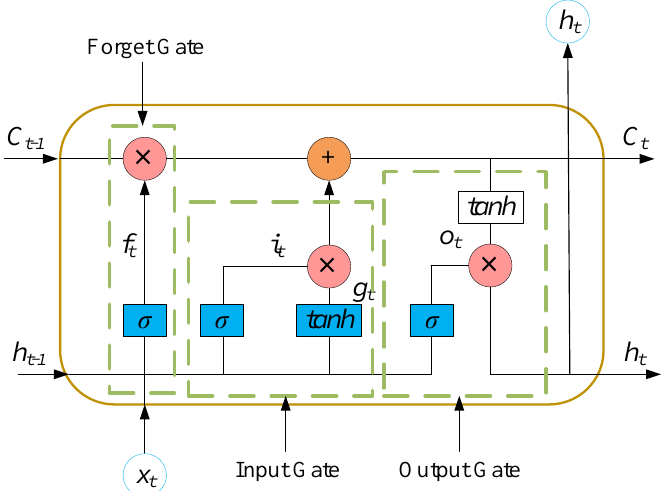
Figure 1. Schematic diagram of the structure of the long short-term memory network.